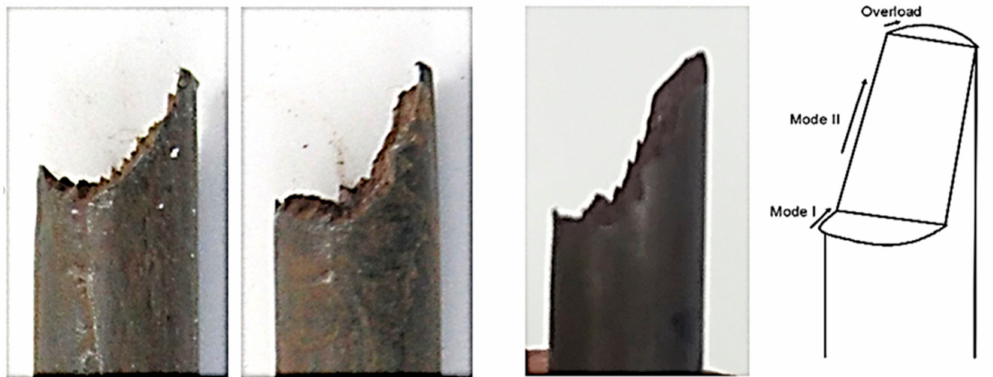
Figure 16. Step-shape fracture surface, Mode I tensile opening and Mode II shear